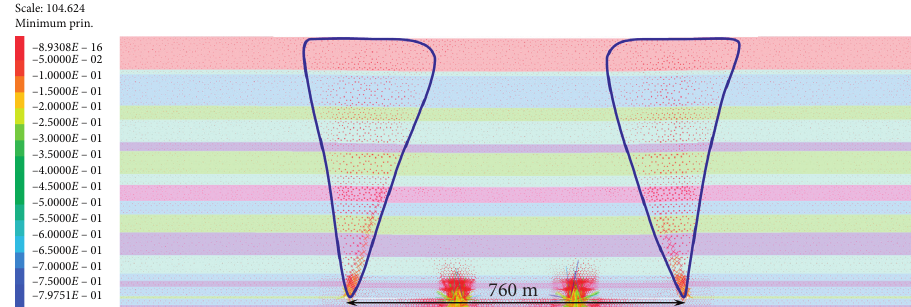
Figure 22: Strain increments of strata after extraction of 31101, 31102, and 31103